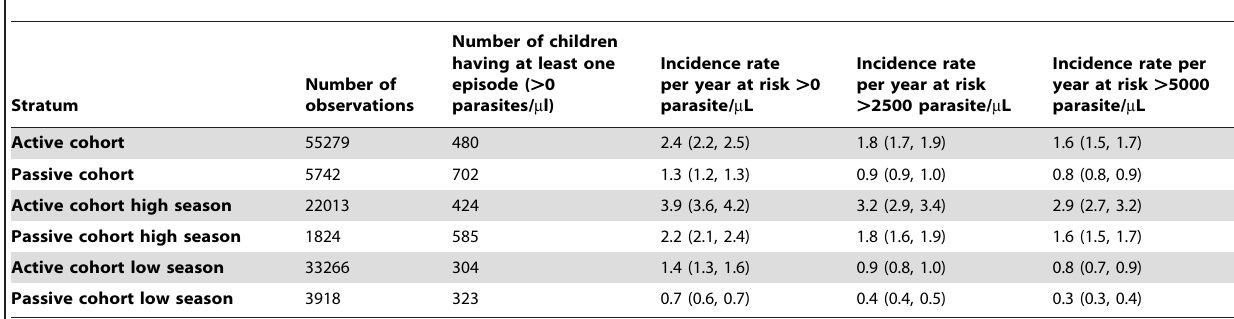
Table 4. Incidence density of malaria episode according to season and different level of parsitemia.